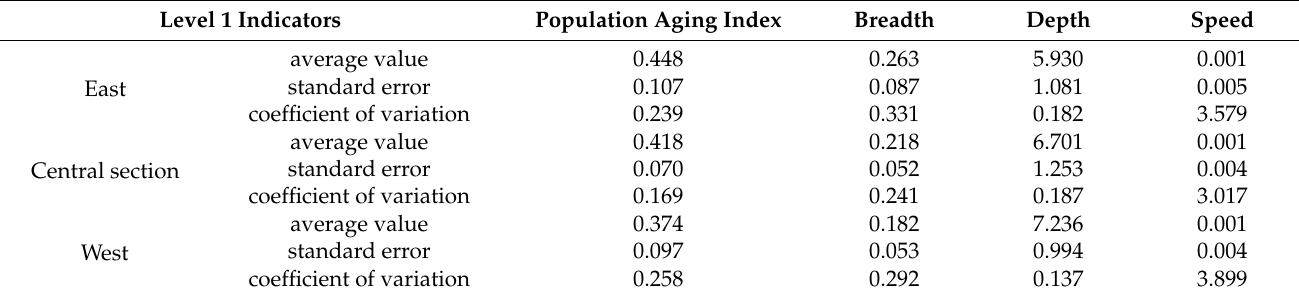
Table 4. Differences in the regional population aging